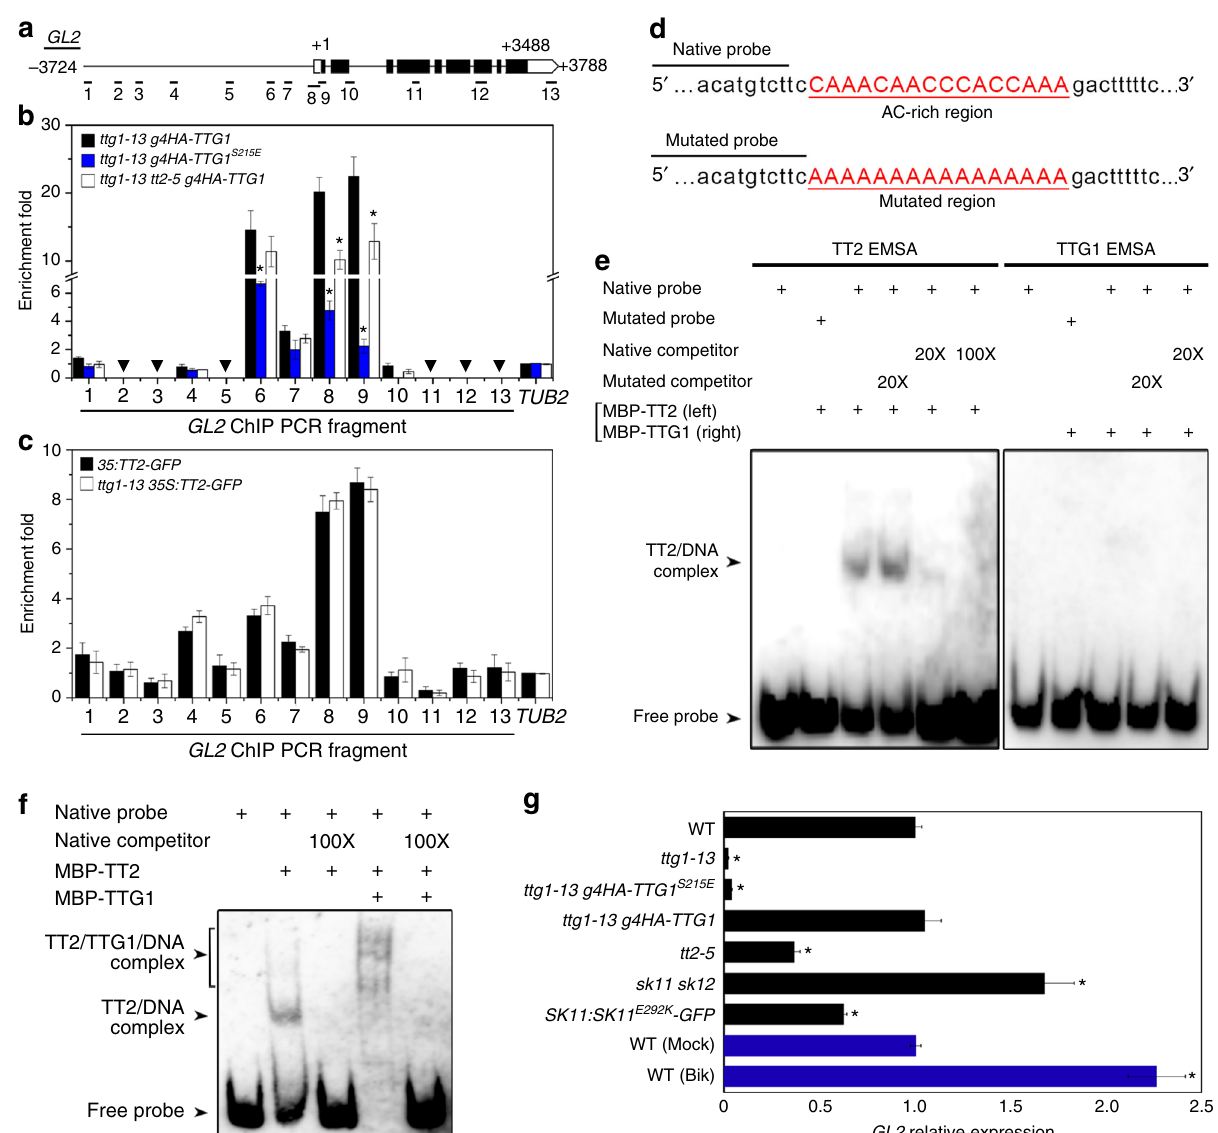
Fig. 7 Phosphorylation of TTG1 at Ser 215 weakens TTG1 binding to the GL2 locus through TT2. a Schematic diagram of the GL2 genomic region. The coding and untranslated regions are indicated by black and white boxes, respectively, while introns and other genomic regions are indicated by black lines. The fi rst nucleotide of the translation start codon is assigned the +1 position, and other sequences are numbered relative to this site. Thirteen DNA fragments (1 – 13) spanning the GL2 locus were designed for ChIP analyses as shown in b , c . b , c ChIP analyses of binding of 4HA-TTG1 variants ( b ) and TT2-GFP ( c ) to the GL2 locus. Chromatin immunoprecipitation analyses were performed on siliques in various genetic backgrounds 4 days after pollination. Nuclear extracts served as the input, while immunoprecipitated fractions by anti-HA antibody ( b ) and anti-GFP antibody ( c ) were used as the eluate. A TUB2 fragment was ampli fi ed as a negative control. Triangles indicate barely detectable amplicons at certain sites. Values are mean ± s.d. of three biological replicates. Asterisks indicate signi fi cant differences in enrichment fold changes in comparison with ttg1-13 g4HA-TTG1 (two-tailed paired Student ’ s t test, P < 0.001). d List of the putative TT2-binding element (native probe) near primer 9 in the GL2 genomic region shown in a , and its mutated version (mutated probe). The mutated AC-rich region is underlined in red. These probes were used for subsequent EMSA assays. e , f EMSA assays of binding of MBP-TT2 ( e , left panel), MBP-TTG1 ( e , right panel), and both proteins ( f ) to the probes shown in c . Recombinant proteins were incubated with biotinylated native or mutated probe. Nonlabeled native or mutated probes in 20- or 100-fold molar excess relative to the biotinylated native probe were used as cold competitors. Supershift complexes were observable ( f ) when MBP-TT2 and MBP-TTG1 were incubated with the biotinylated native probe. g Quantitative real-time PCR analysis of GL2 expression in siliques in various genetic backgrounds 4 days after pollination. Wild-type siliques mock-treated (Mock) or treated with 25 μ M bikinin (Bik) for 2 h were collected for expression analysis shown in blue bars. Expression values normalized against the expression levels of U-BOX are shown relative to the level in wild-type siliques set as 1. Values are mean ± s.d. of three biological replicates. Asterisks indicate signi fi cant differences in GL2 expression between indicated genotypes and wild-type plants (black bars) or between bikinin- or mock-treated wild-type plants (blue bars) (two-tailed paired Student ’ s t test, P < 0.001). Uncropped original scans of immunoblots are shown in Supplementary Fig.